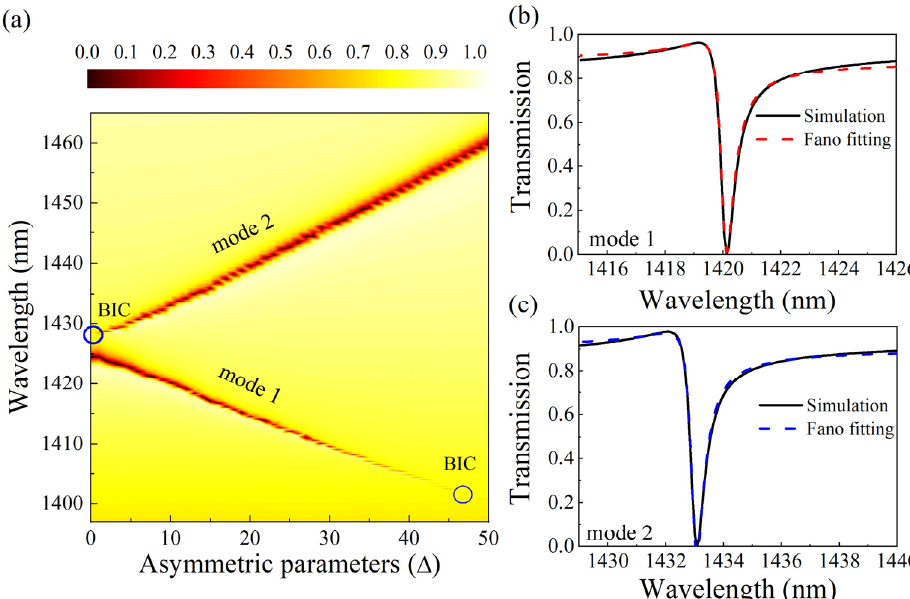
Figure 2. Metasurface transmission spectrum analysis. ( a ) Transmission spectra of metasurfaces under different asymmetric parameters; ( b , c ) Fano fitting of transmission spectra of mode 1 and mode 2, respectively, at ∆ = 10 nm; the solid line represents the simulation result, and the dashed line represents the fitting result of the Fano formula.